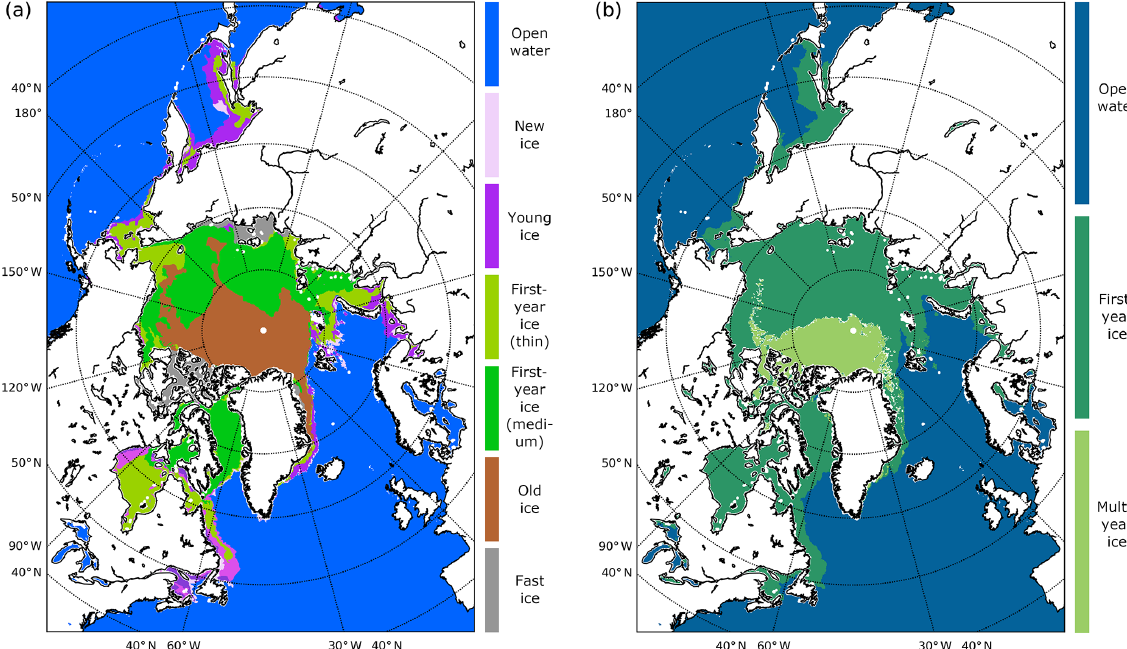
Figure 12. The ice types in NIC ice chart (a) and OSI SAF sea ice type product (b) for the same date (8 February 2019). Note that the SoD labels and colours follow those defined in each ice chart format. Source credits: U.S. National Ice Center (a) and EUMETSAT Ocean and Sea Ice Satellite Application Facilities (b) . Table 10. Confusion matrix of the three-class RF classifier which was trained and applied to the DS1 winter dataset. The bold font indicates where the classification was done correctly. Predicted OW (open water) mFYI (mixed first-year ice) OI (old ice) Case FC1 FC2 FC3 FC1